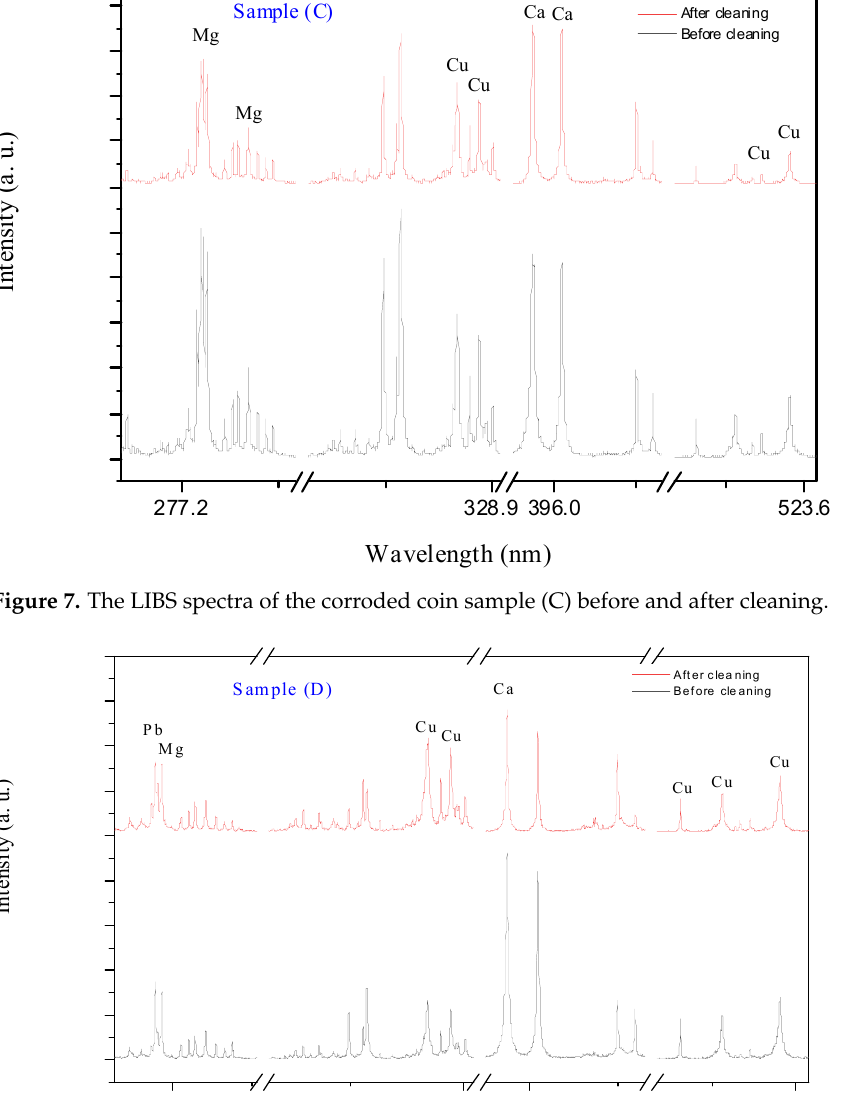
Figure 8. The LIBS spectra of the corroded coin sample (D) before and after cleaning.